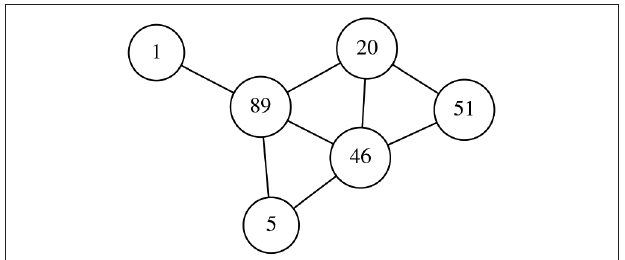
FIGURE 4 | Example of the generation of an undirected network from a decimal series defined as (51,46,5,89,46,20,51,20,89,1).